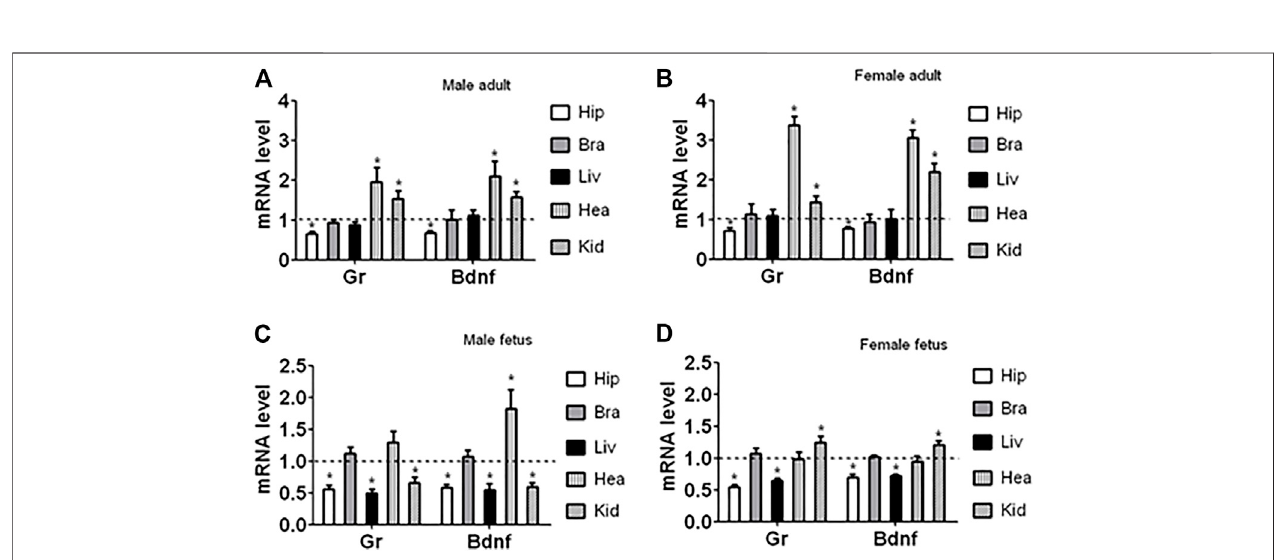
FIGURE 3 | Expression of Gr and Bdnf mRNAs in different organs of adult and fetal offspring after ECC. The organs observed included hippocampus (Hip), brains with hippocampus removed (Bra), liver (Liv), heart (Hea) and kidney (Kid) from adult and fetal male and female offspring. Relative mRNA levels in the corticosterone- treatedoffspringwerecalculatedrelativetothoseinthecontroloffspringfromembryosculturedwithoutcorticosterone,whichweresetto1(dottedline).Eachtreatment wasrepeated sixtimes with each replicate containingorgans from one animal from adifferentlitter. *Indicatesasigni fi cantdifference( p < 0.05) from offspring from embryos cultured without